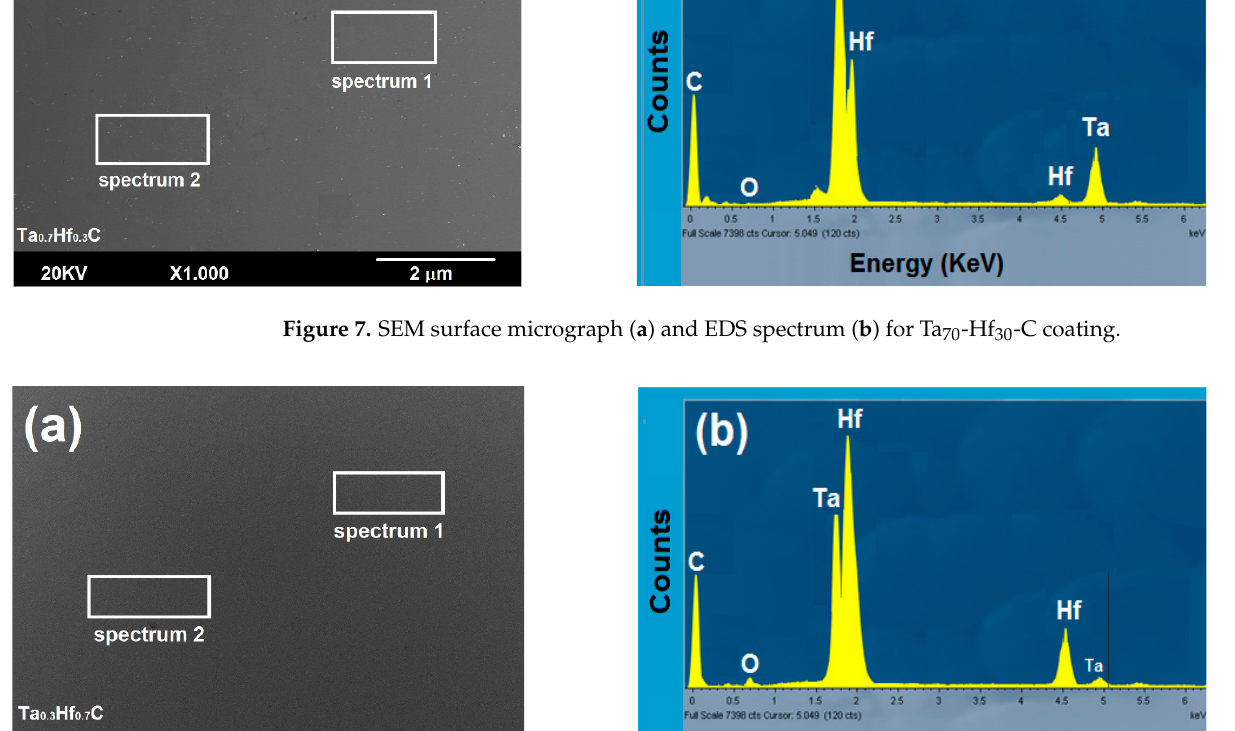
Figure 8. SEM surface micrograph ( a ) and EDS spectrum ( b ) for Ta 30 -Hf 70 -C coating.